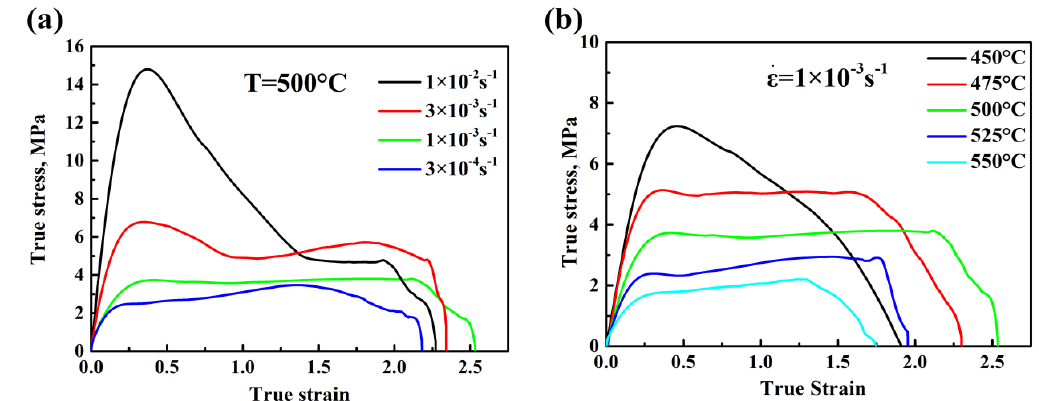
Figure 6. The true stress–true strain curves, ( a ) at different strain rates at 500 °C; ( b ) at different temperatures at 1 × 10 −3 s −1 .